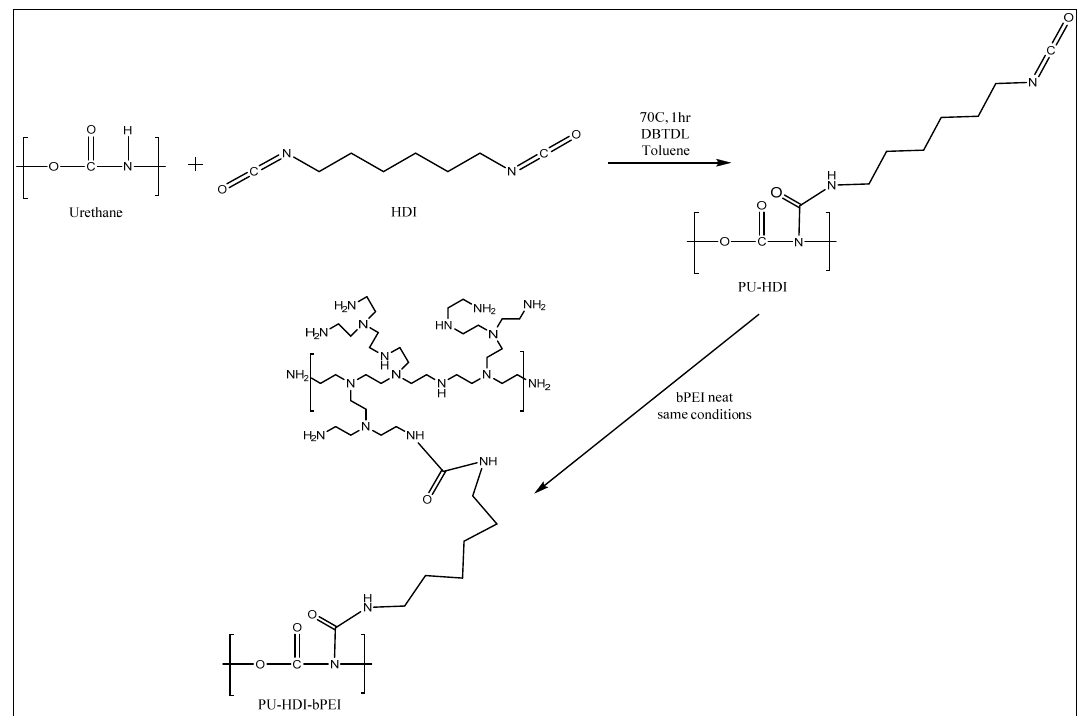
Figure 4. ATR-FTIR spectra of functionalized PU surface (PU-HDI); PU neat and HDI reagent.